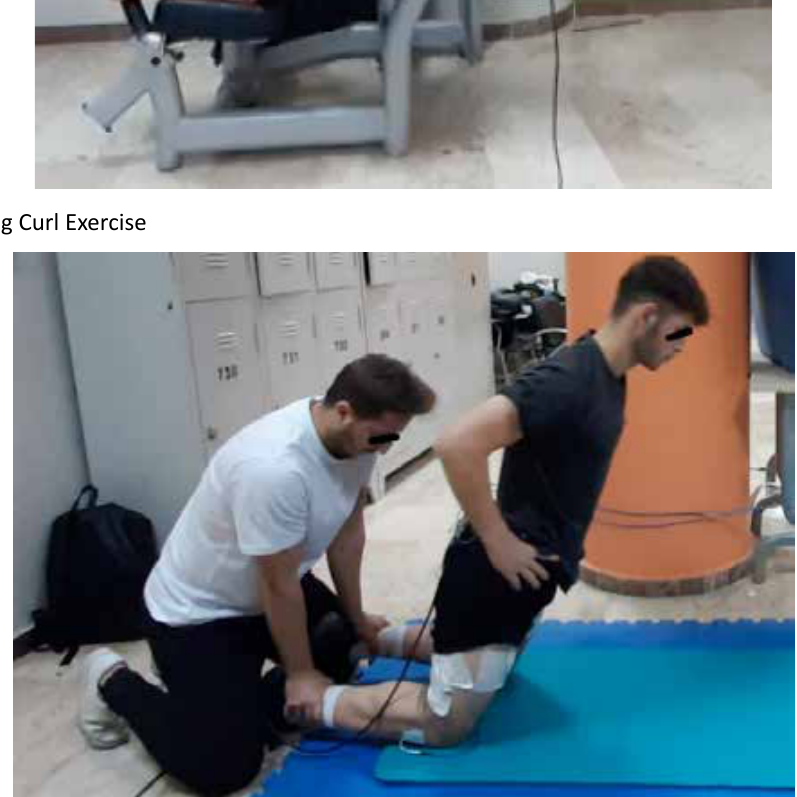
Figure 4. Nordic Curl Exercise